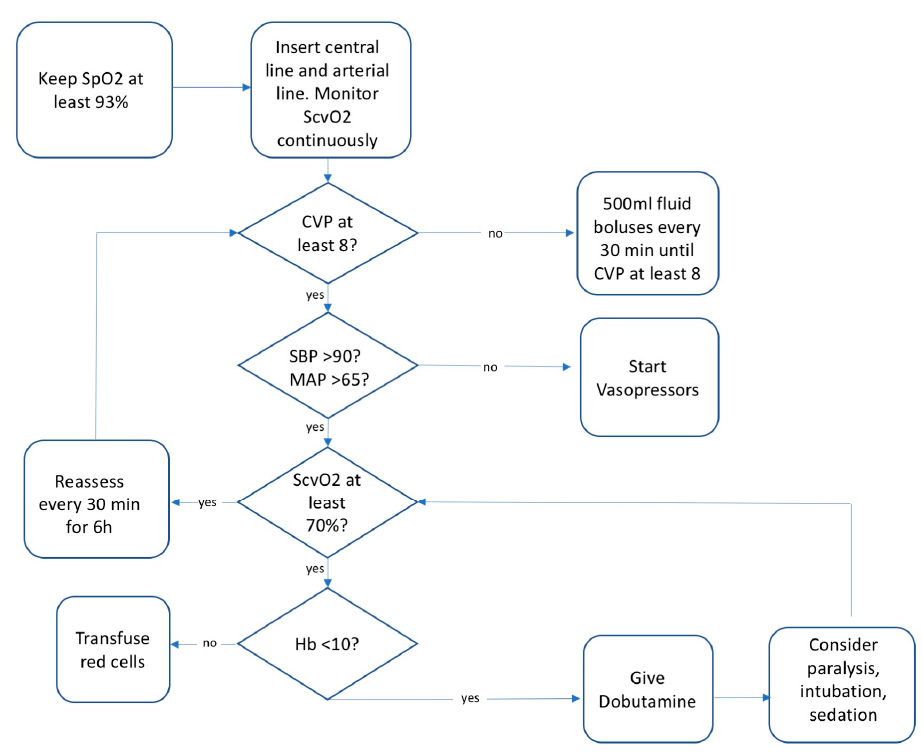
Figure 1. Early goal-directed therapy (EGDT) algorithm of care that was randomized to the treatment of a group of patients with septic shock in the ProMISe trial. For the 1251 patients in this large trial, there was no difference in 90-day mortality, indicating that EGDT does not improve outcomes in sepsis. SpO 2 , oxygen saturation; CVP, central venous pressure; SBP, systolic blood pressure; SCVO 2 , central venous oxygen saturation; Hb, hemoglobin.